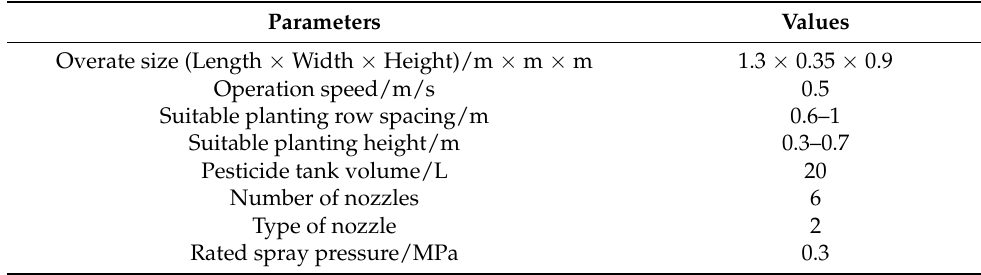
Table 1. Main technical parameters of the sprayer.